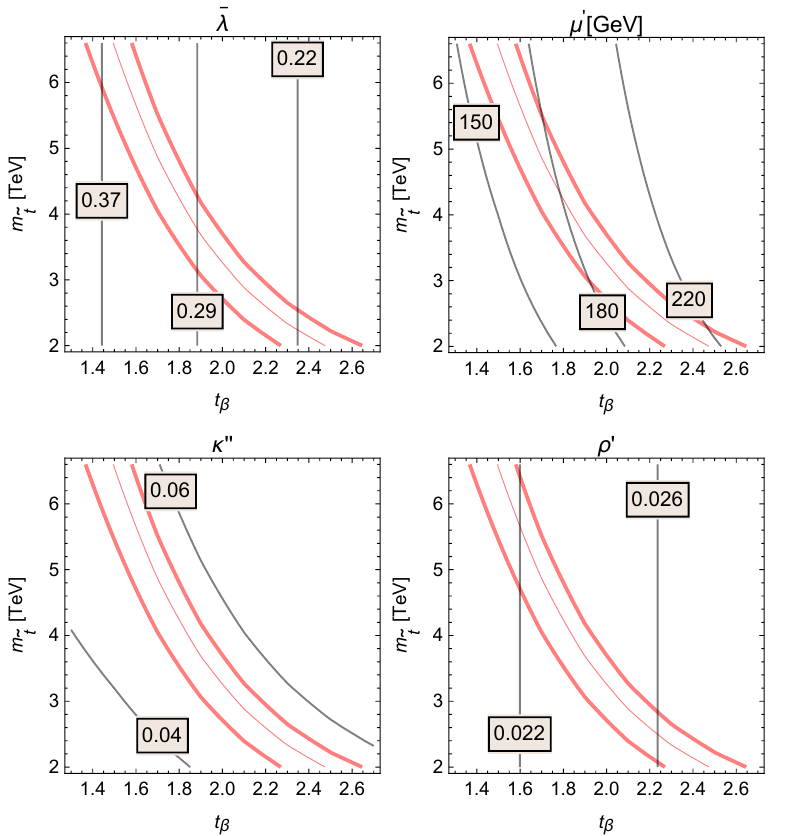
Figure 7 . The e(cid:11)ective quartics and soft Z 2 breaking term in the low-energy TMNT potential arising from a F -term supersymmetric UV completion with the speci(cid:12)c values of input parameters listed in table 2. The red band indicates the Higgs mass window (122 GeV, 128 GeV). The scale F increases slightly with (cid:22) (cid:21) and is around 1.3 TeV everywhere.